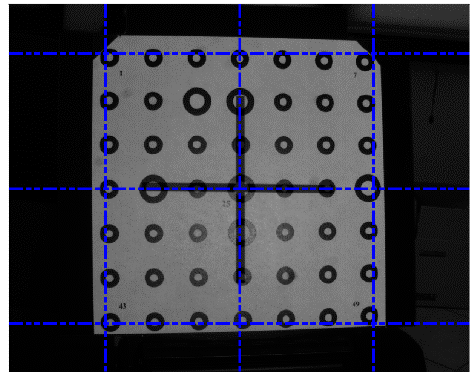
Figure 4. The optical alignment.